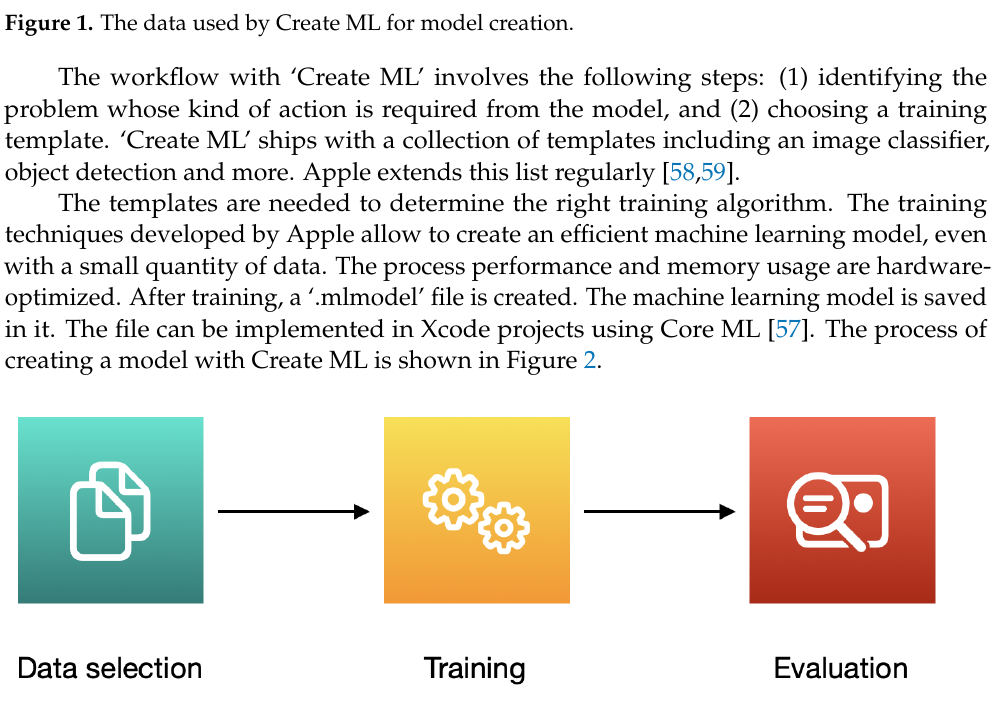
Figure 2. The process of creating a model with Create